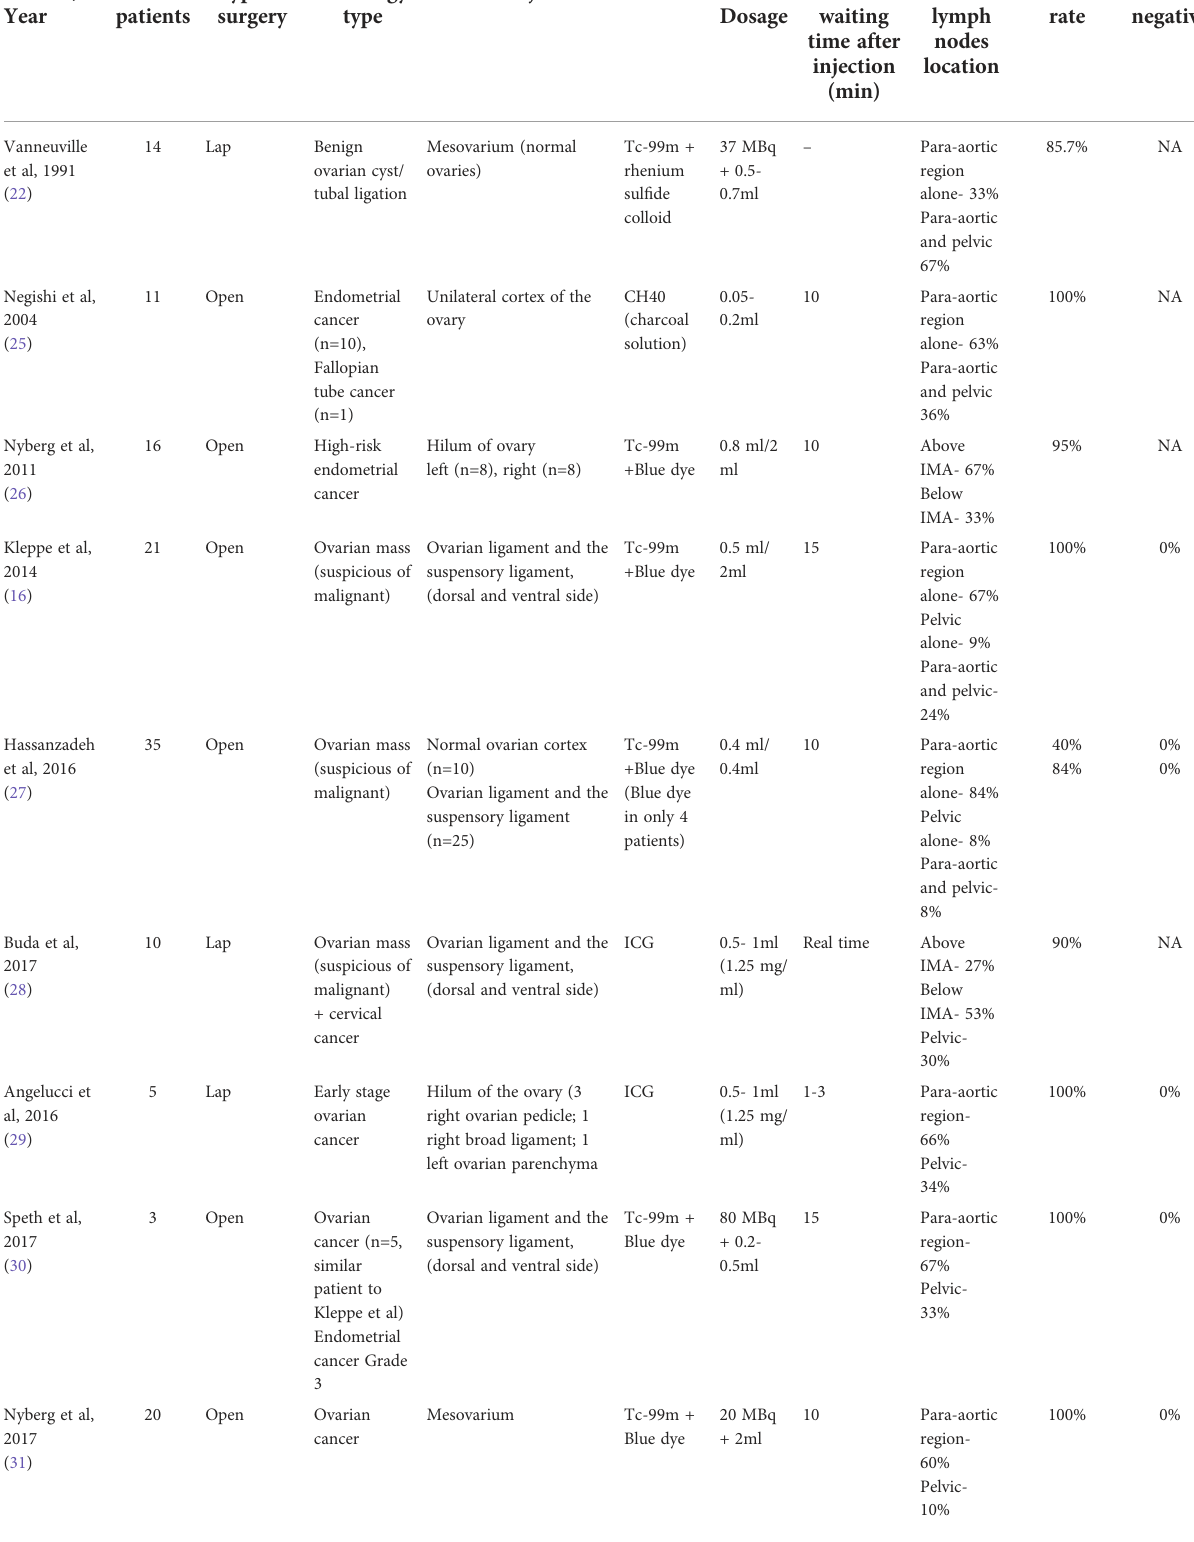
TABLE 1 Study characteristics of ovarian sentinel node mapping